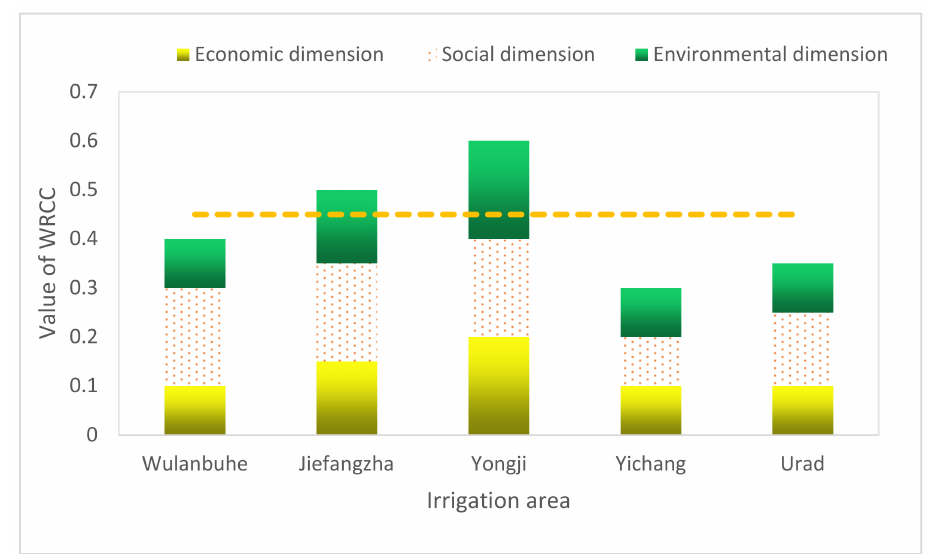
Figure 8. Water resource carrying capacity for different subareas in HID. (Note: (1) WRCC means water resource carrying capacity; and (2) the yellow, dashed line is the average value of WRCC in the different subareas of